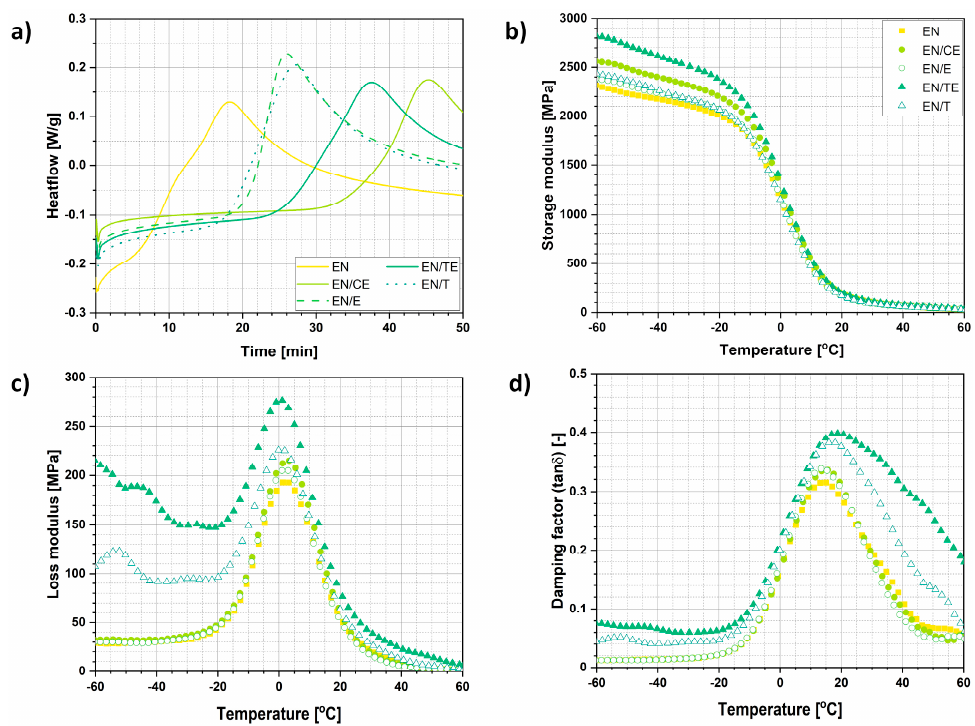
Figure 5. Results of additional tests performed for ethylene–norbornene copolymer specimens: oxidation induction time experiment ( a ), dynamic mechanical analysis performed from –60 to 60 °C, and the representation of changes in storage modulus ( b ), loss modulus ( c ), and damping factor ( d ). Table 2. Parameters assigned to the thermal decomposition and the oxidation process of analyzed samples; T x —tempera- ture at which the mass loss of x% is detected.